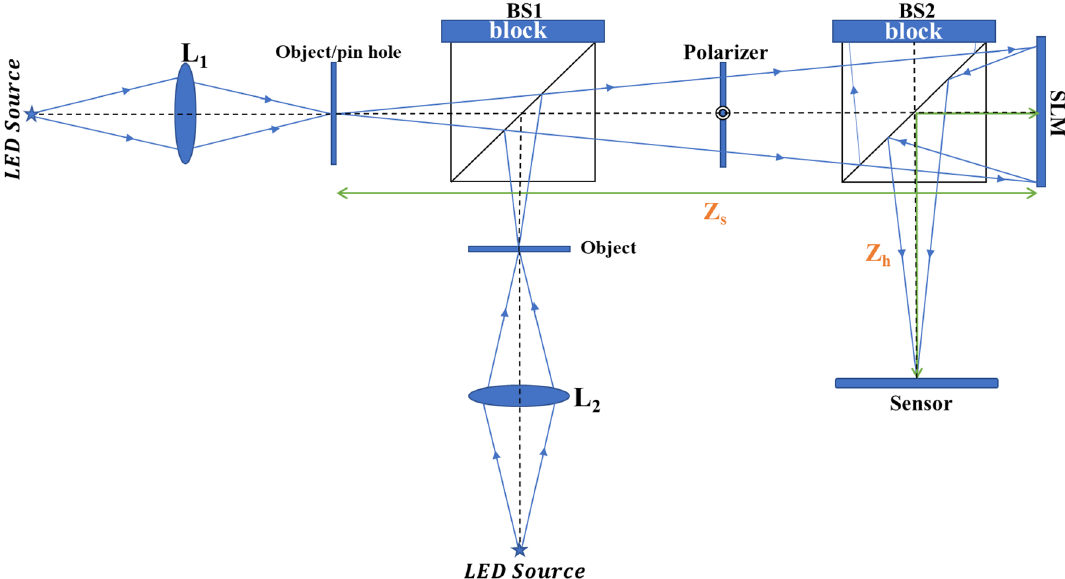
Figure 2. Experimental setup of SCI-COACH